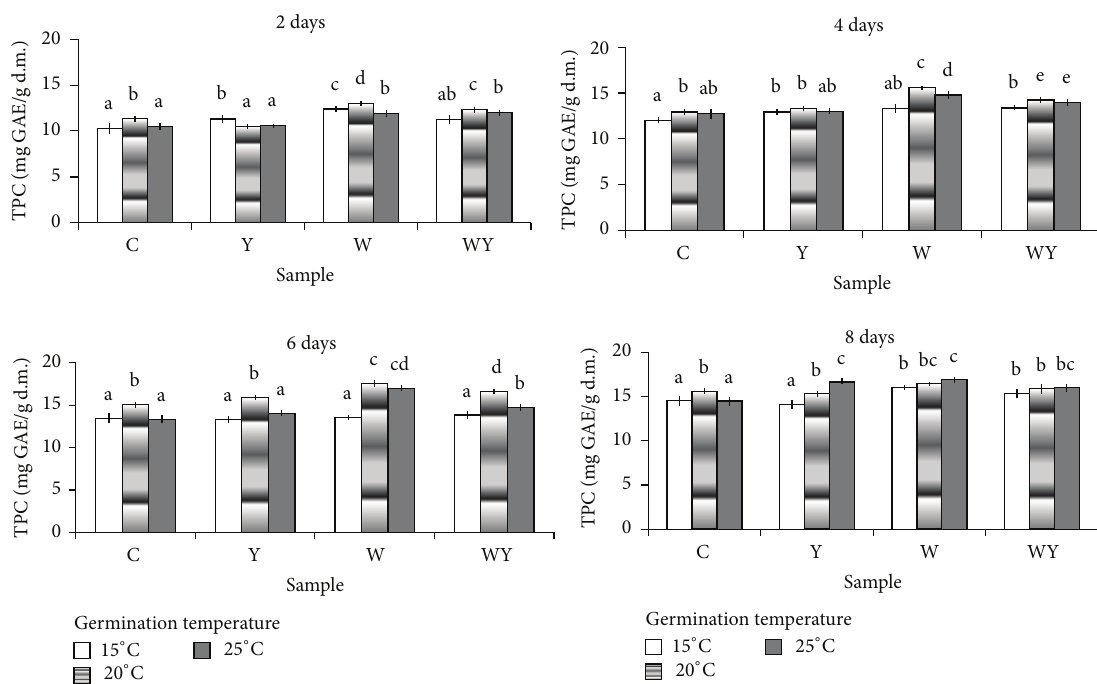
Figure 2: Total phenolics content in control and elicited sprouts depending on time of germination and germination temperature (cv. Mulan); the values designated by the different letters for individual days of sprouting are significantly different ( 𝛼 = 0.05); C represents control sprouts, Y represents sprouts elicited by yeast, W represents sprouts elicited by willow, and WY represents sprouts elicited by willow/yeast mixture.